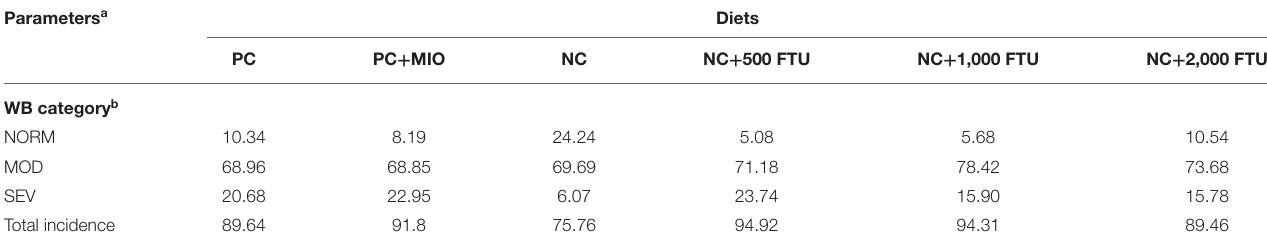
TABLE 5 | Effects of quantum blue supplementation on WB incidence (%) in broilers. Parameters